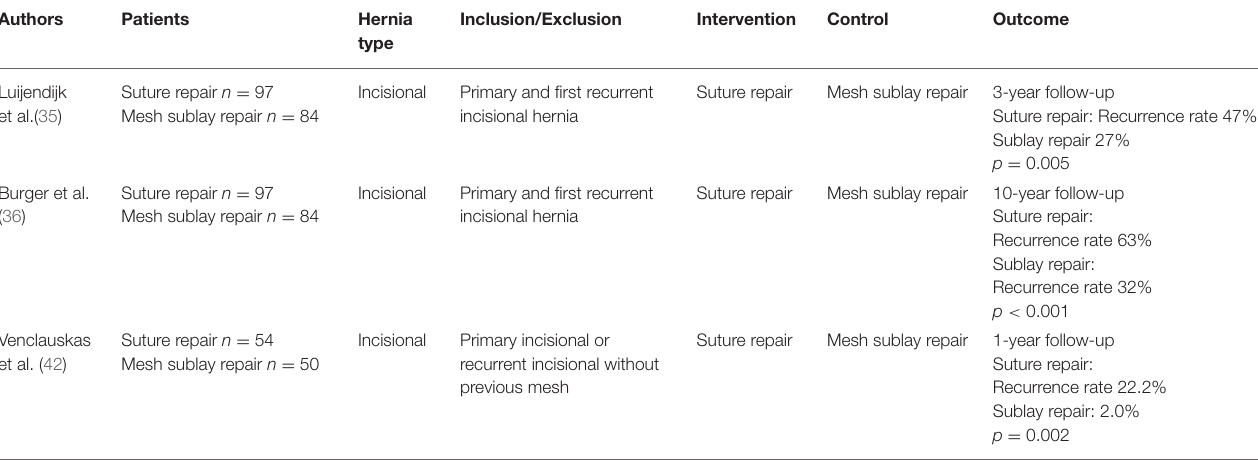
TABLE 2 | RCTs comparing suture vs. mesh sublay/retro-rectus technique in incisional hernia repair.